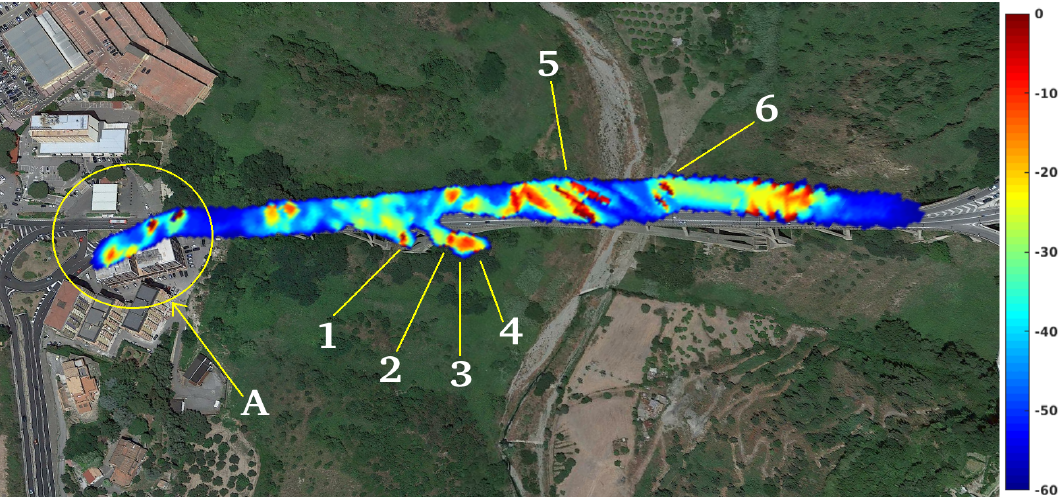
Figure 16. ( a ): “Bisantis” bridge SLC SAR ROI, ( b ): “Italia” bridge SLC SAR ROI.